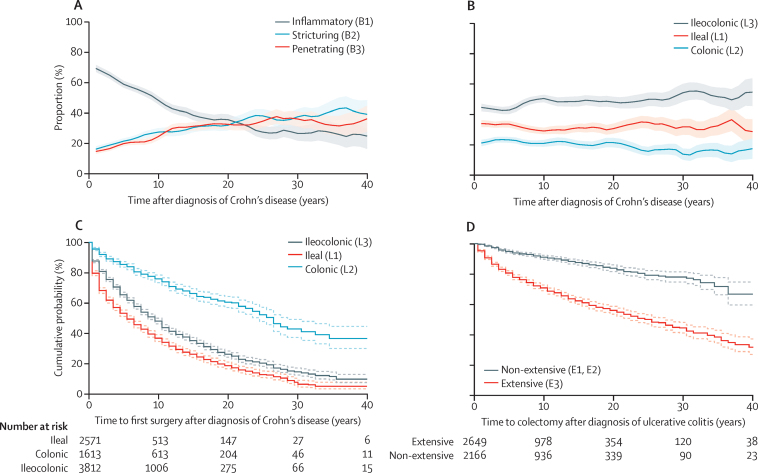
Evolution of clinical subphenotypes(A) Proportion of patients with Crohn's disease who have inflammatory (Montreal classification B1), stricturing (B2), or penetrating (B3) disease over time from diagnosis to most recent follow-up. (B) Proportion of patients with Crohn's disease who have ileal (L1), colonic (L2), or ileocolonic (L3) disease over time from diagnosis to most recent follow-up. (C) Survival plot of time from diagnosis of Crohn's disease to resectional surgery stratified by disease location. (D) Survival plot of time from diagnosis of ulcerative colitis to colectomy stratified by disease extent (extensive disease, E3; non-extensive disease, E1 and E2).